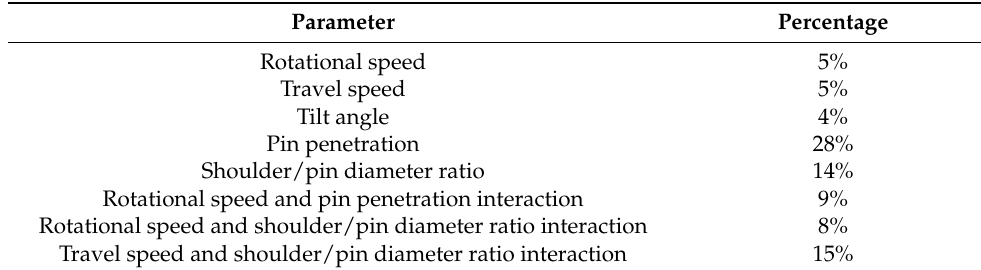
Table 2. Percentage of butt joints parameters. Parameter Percentage Rotational speed 5% Travel speed 5% Tilt angle 4% Pin penetration 28% Shoulder/pin diameter ratio 14% Rotational speed and pin penetration interaction 9% Rotational speed and shoulder/pin diameter ratio interaction 8% Travel speed and shoulder/pin diameter ratio interaction